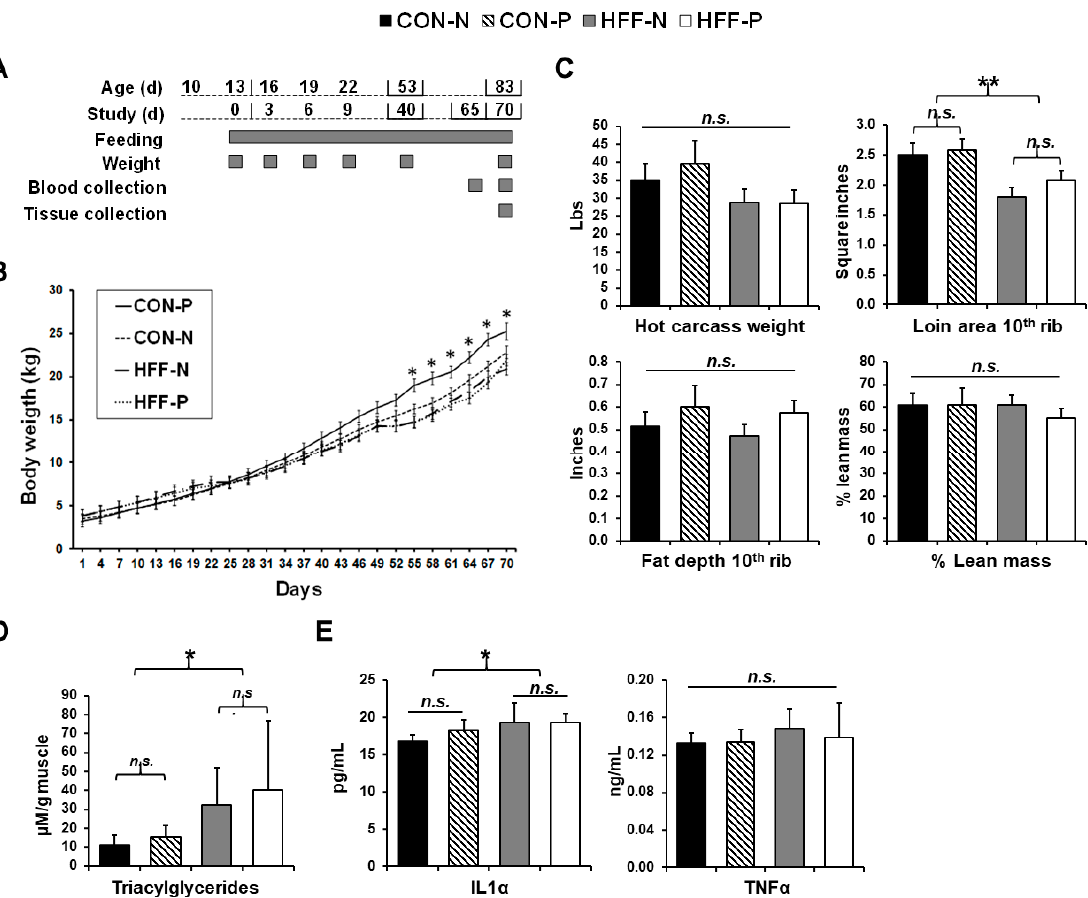
Figure 1. Lipid accumulation and inflammation in skeletal muscle of juvenile Iberian pigs fed high-fructose, high-fat diets (HFF) in the absence of overall changes in body composition. ( A ) Age of pigs related to study and feeding duration and weight, blood, and tissue collection points; ( B ) pig body weight (kg) throughout the duration of the study. A significant increase in the body weight of pigs fed a control diet with probiotic supplementation occurs beginning on day 55; ( C ) hot carcass weight (lbs), loin area at 10th rib (in 2 ), and fat depth at 10th rib (in) were used to calculate lean mass percentage with the formula 100% × [8.588 + (0.465 × hot carcass weight) − (21.896 × 10th rib fat depth) + (3.005 × 10th rib loin muscle area)]/hot carcass weight to reveal no significant differences in lean mass or overall body composition between the groups; ( D ) triacylglycerol content ( μ M/g of muscle) of the longissimus dorsi muscle demonstrating a significant increase in lipid accumulation in HFF-fed pigs with a slight ameliorative effect observed with probiotic supplementation; ( E ) interleukin 1 alpha (IL-1 α , pg/mL) and tumor necrosis factor-alpha (TNF α , ng/mL) content of the longissimus dorsi muscle with a sig- nificant increase in IL-1 α in HFF-fed versus CON-fed pigs. CON—control; CON-N—control diet without probiotic sup- plementation; CON-P—control diet with probiotic supplementation; HFF-N—high-fructose, high-fat diet without probi- otic supplementation; HFF—P-high-fructose, high-fat diet with probiotic supplementation; cm — centimeter; Mm — milli- molar; g--gram; kg — kilogram; pg — picogram; ng — nanogram; mL — milliliter. Statistical significance between groups is indicated by * ( p ≤ 0.05), ** ( p ≤ 0.01). Non-significant differences between groups are indicated by “n.s.’’. Samples of longissimus dorsi muscle samples were obtained from 20 pigs immedi- ately after euthanasia and dissected free of connective tissue. Samples for gene expression analysis were placed in 2 mL cryotubes and frozen by immersion in liquid nitrogen. Mus- cle samples for histology were placed on slices of cork, covered in optimum cutting tem- perature compound (Tissue-Tek Cryomold Standard; Sakura, Torrance, CA, USA), and frozen by immersion in isopentane suspended in liquid nitrogen. Samples were stored at − 70 °C until analysis.